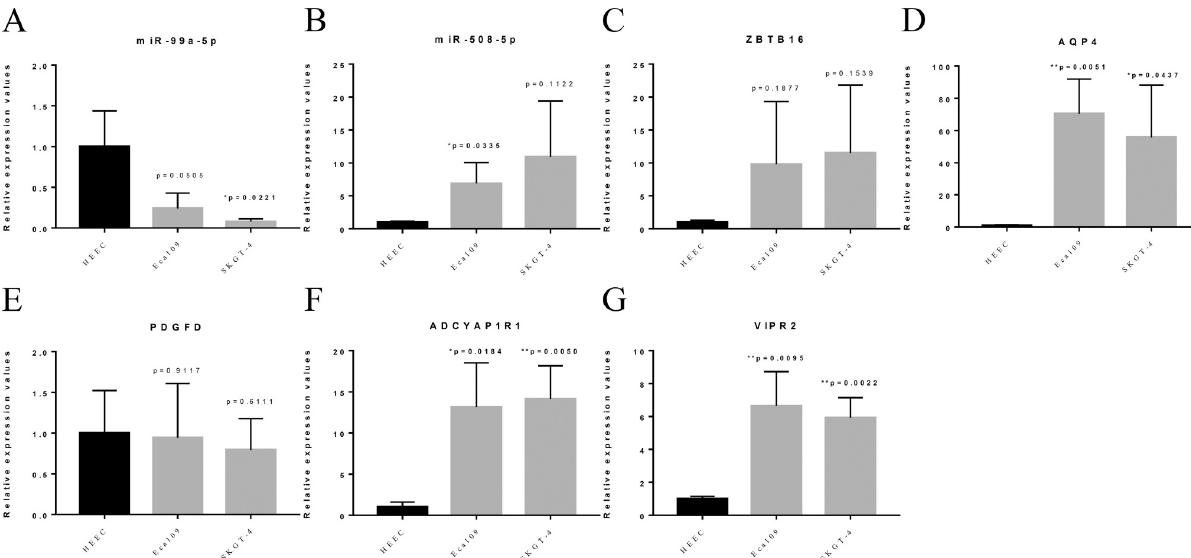
Fig 6. Relative expression of markers. (A-G) denote the expression of miR-99a-5p, miR-508-5p, ZBTB16, AQP4, PDGFD, ADCYAP1R1 and VIPR2, respectively. qPCR results showed that: (A) miR-99a-5p was significantly down-regulated in human esophageal cancer SKGT-4 cells compared with HEEC cells, and the difference was statistically significant. The differences were statistically significant. (B) The relative expression levels of miR-508-5p were significantly up-regulated in human esophageal cancer ECA109 cells compared with HEEC cells, and the differences were statistically significant. The relative expression levels of AQP4, ADCYAP1R1 and VIPR2 were significantly upregulated in human esophageal cancer SKGT-4 and ECA109 cells, and the differences were statistically